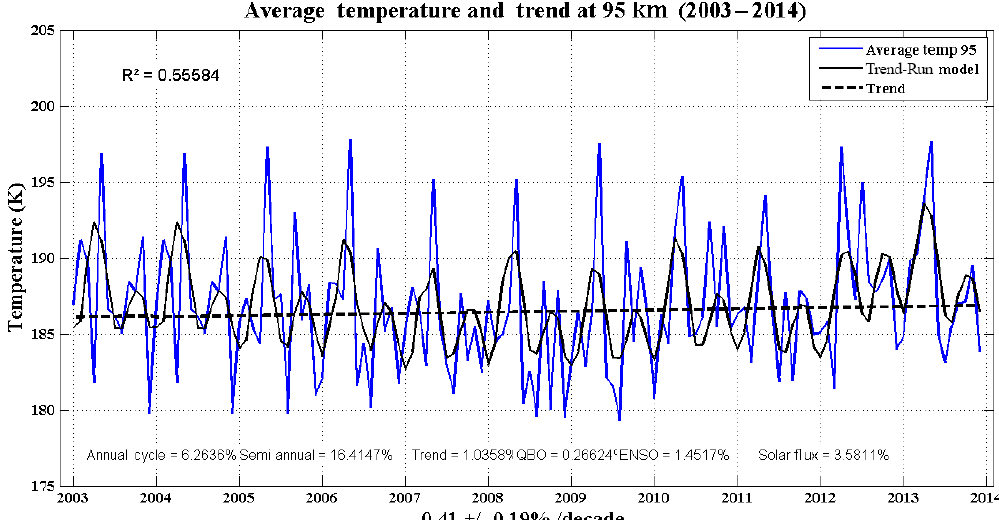
Figure 8. Time evolution of monthly averaged temperature values at 95km height over Santa Maria, within a ± 7.5 ◦ grid. The obtained linear trend is + 0.41 ±− 0.19%Kdecade − 1